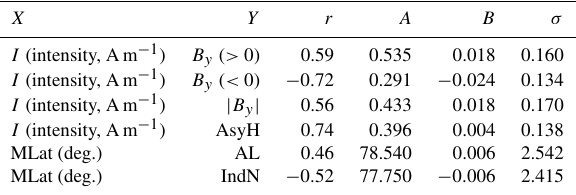
Table 2. Correlations of the PE current system with various indices. The columns show the dependent ( X ) and independent variable ( Y ), their correlation coefficients ( r ), the coefficients A and B of the regression equations X = A + B × Y , and their dispersions σ